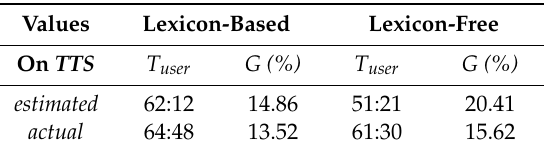
Table 4. Comparison between the values provided by our model and the actual ones on TTS . Times are expressed in the format